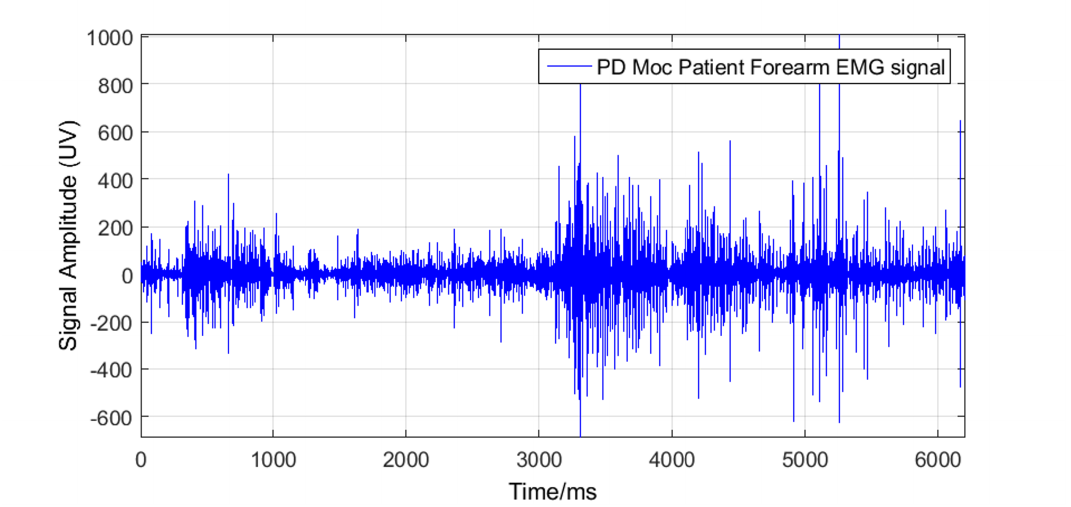
Figure 6. EMG (forearm) signal of the PD patient.